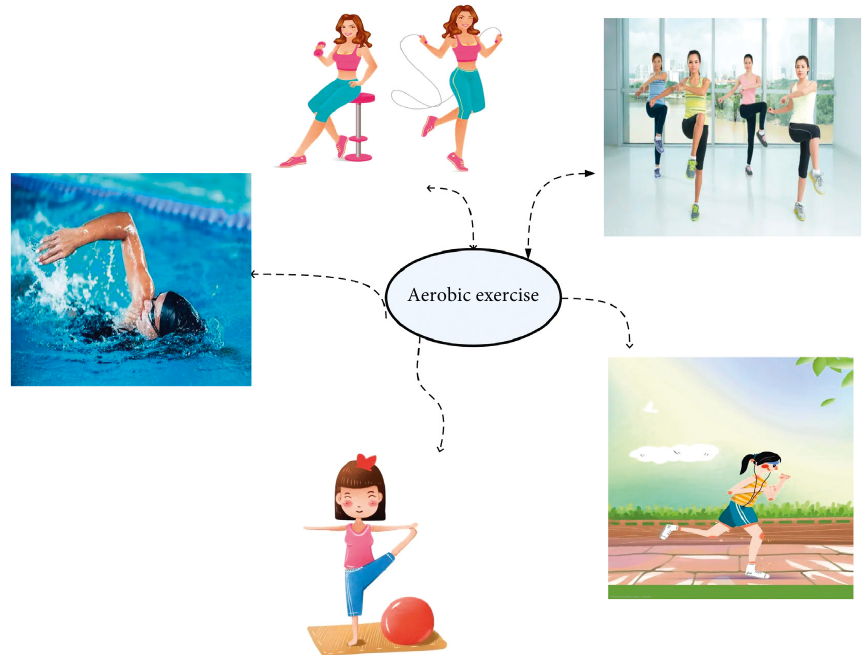
Figure 7: Some common forms of aerobic exercise.